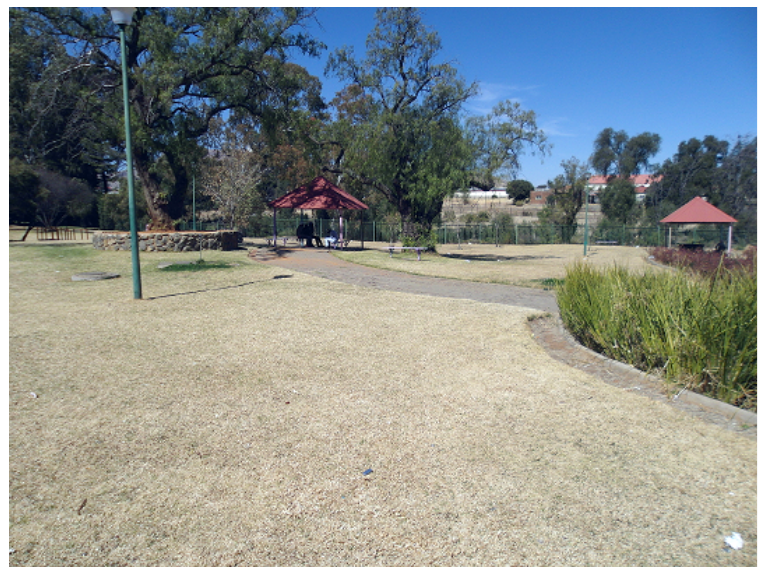
Figure 7. The laid-back rhythm of Old Regional Park. Source: photograph by